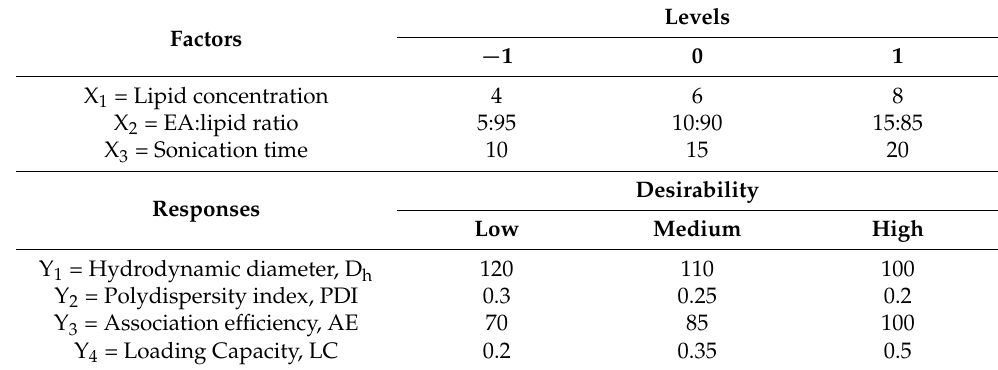
Table 1. Factors and responses considered in the Box–Behnken factorial design and the corresponding tested levels and defined desirable criteria